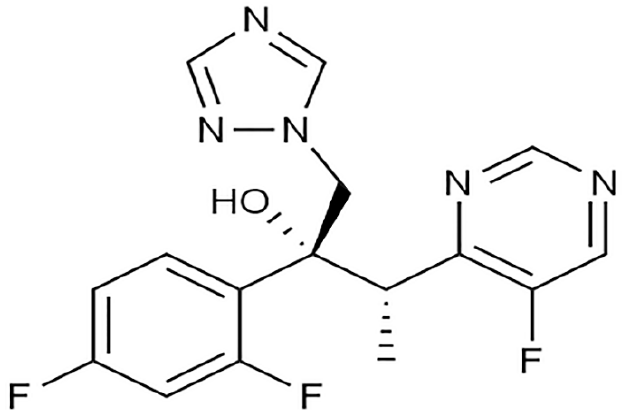
Figure 4. Chemical structure representing Voriconazole.